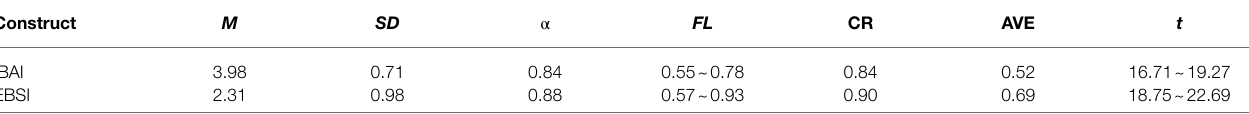
TABLE 3 | Reliability and Validity Analysis.